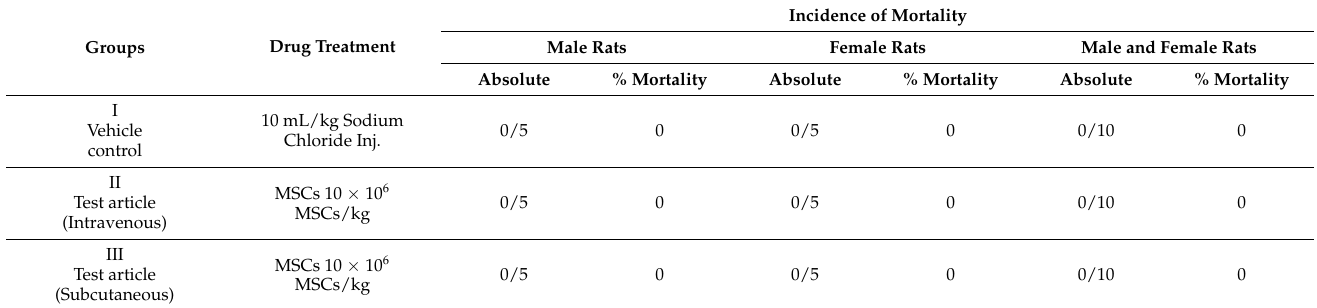
Table 1. Summary of Mortality.